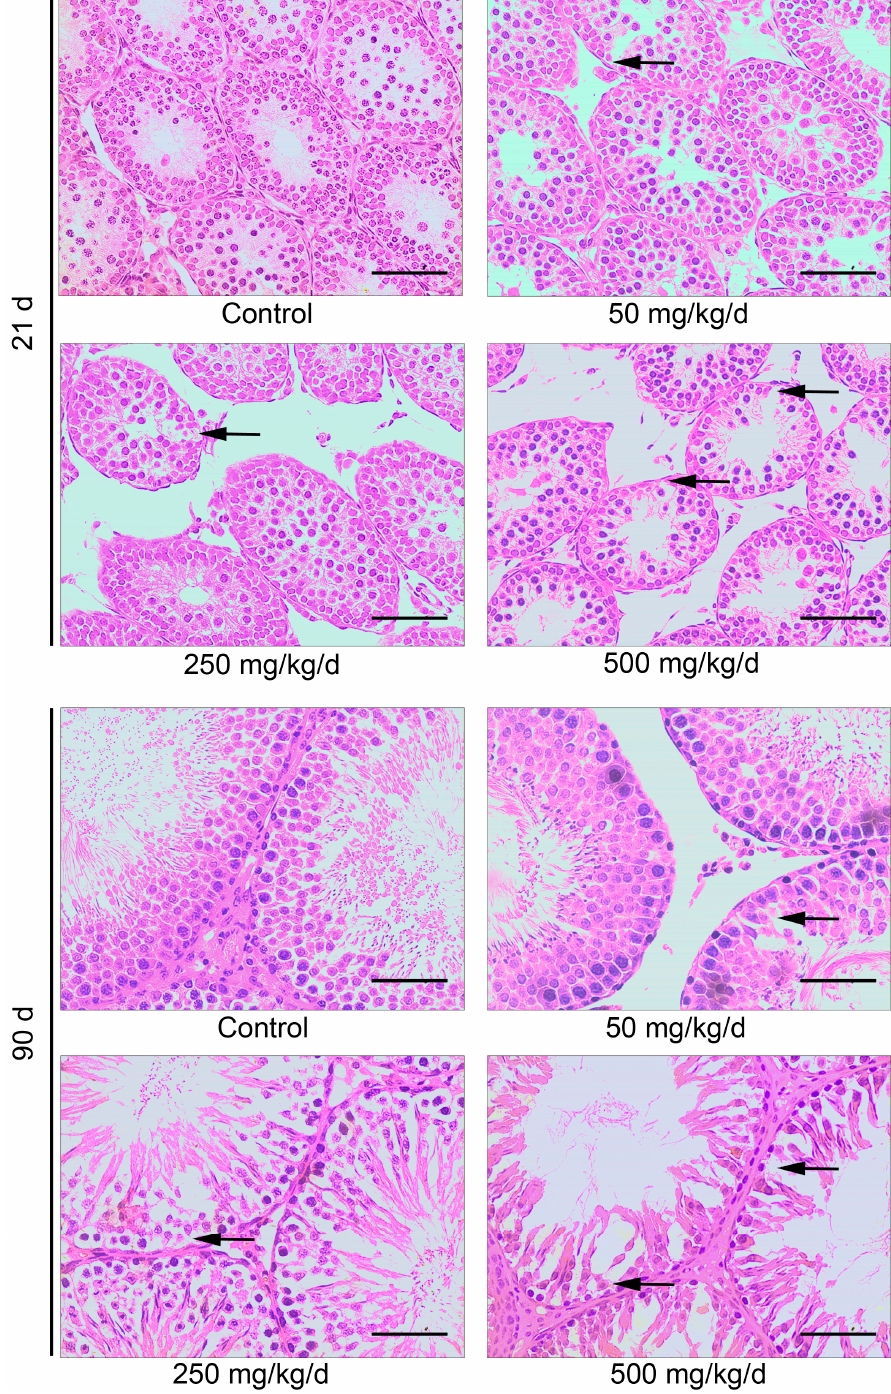
Figure 2. The impact of DBP on histologic structure of testis was determined by hematoxylin-eosin (H&E) staining. The arrows indicate the loss of cells in the seminiferous tubules. Scale bar = 100 μ m.